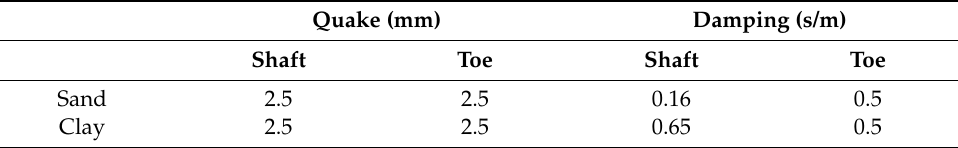
Table 1. Quake and damping values used in SRD